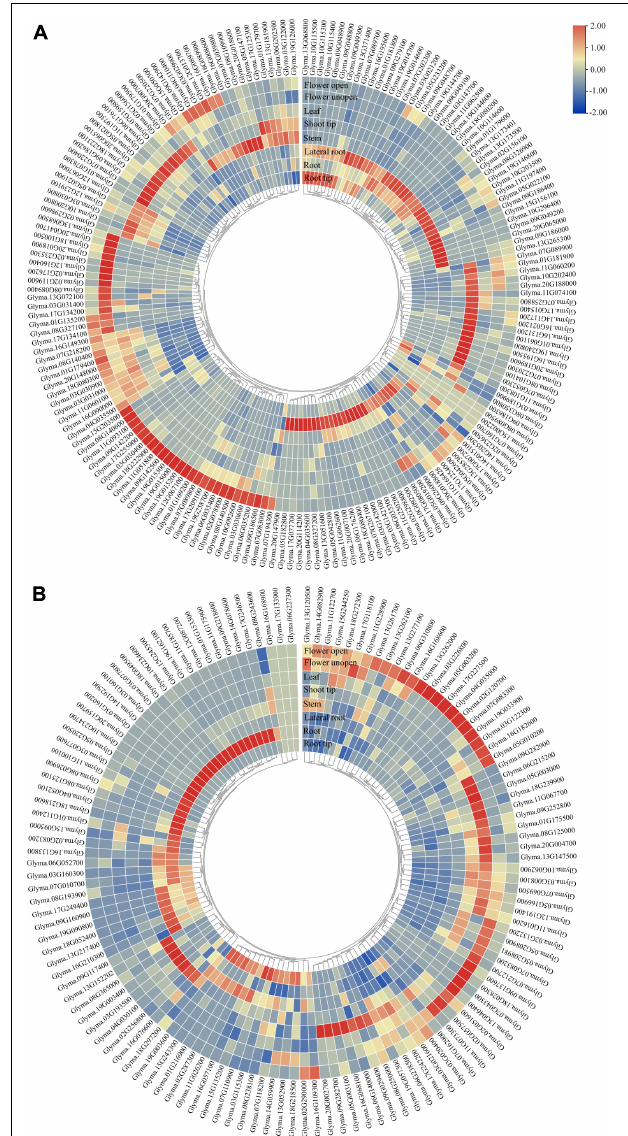
FIGURE 5 | Tissue-specific expression of GmP450 gene family. Publicly available transcriptomic data for GmP450 genes in soybean tissues were retrieved from Phytozome13 database (https://phytozome-next.jgi.doe.gov/info/Gmax_Wm82_a4_v1) for